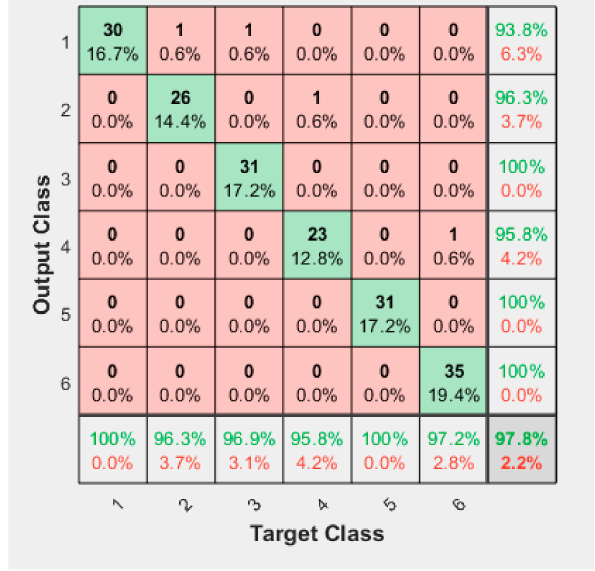
Figure 11. Confusion matrix for classification model with db6